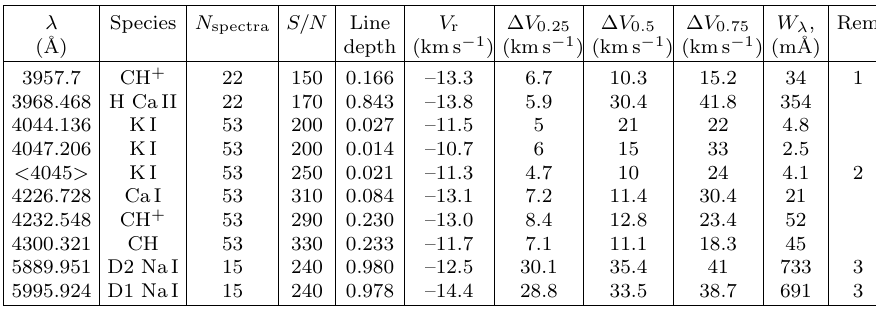
Table 2. Interstellar lines in the optical spectra of Cyg